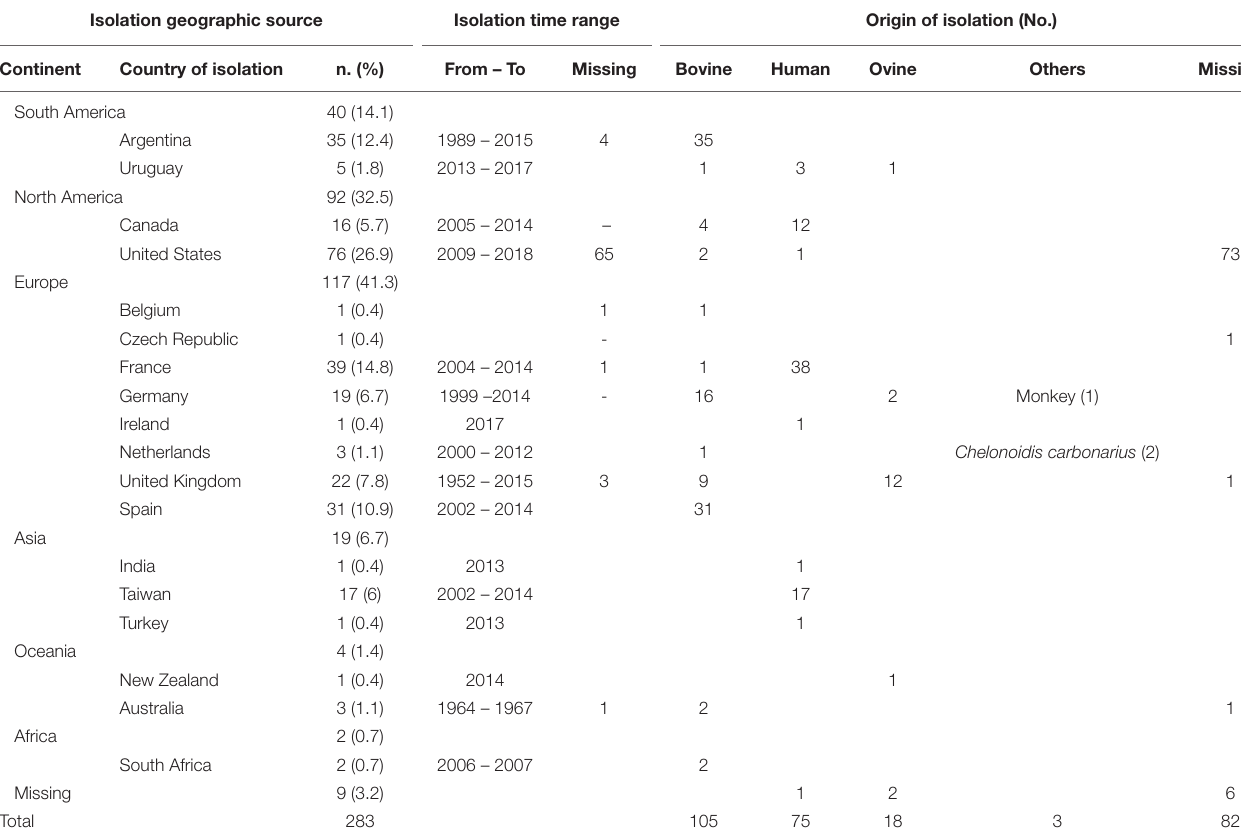
Isolation geographic